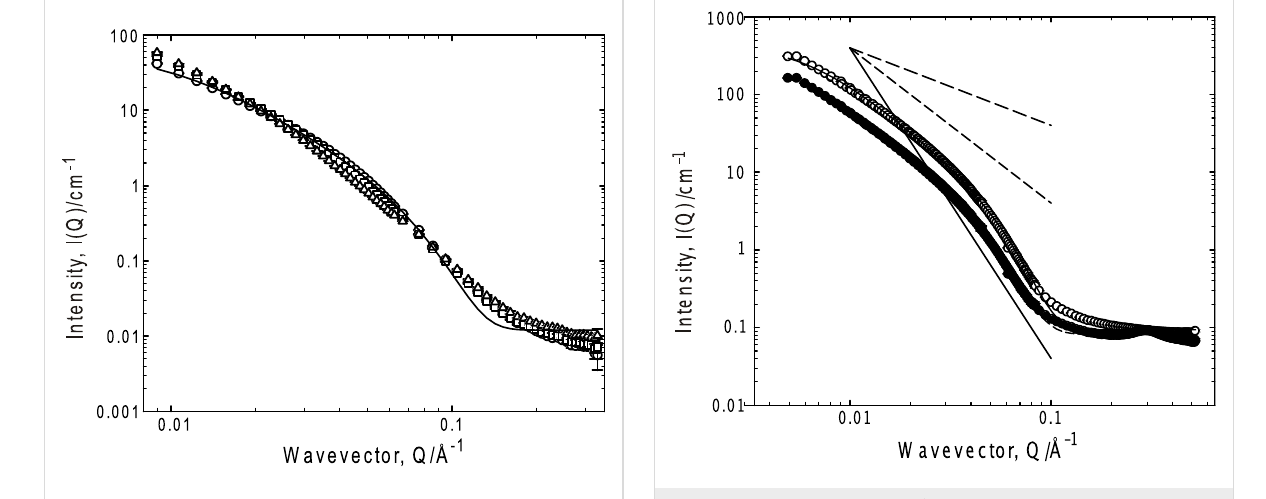
Figure 6: SANS from 35 mg ml − 1 G 6 in 75% d- ethanol/25% D 2 O, 37 °C; hydrogenous gelator (empty symbols) and partially deuterated gelator (filled symbols). Fits to the Kholodenko–Dirac worm model are superimposed on the data. Limiting behaviors of Q − 1 , Q − 2 and Q − 4 are also shown.